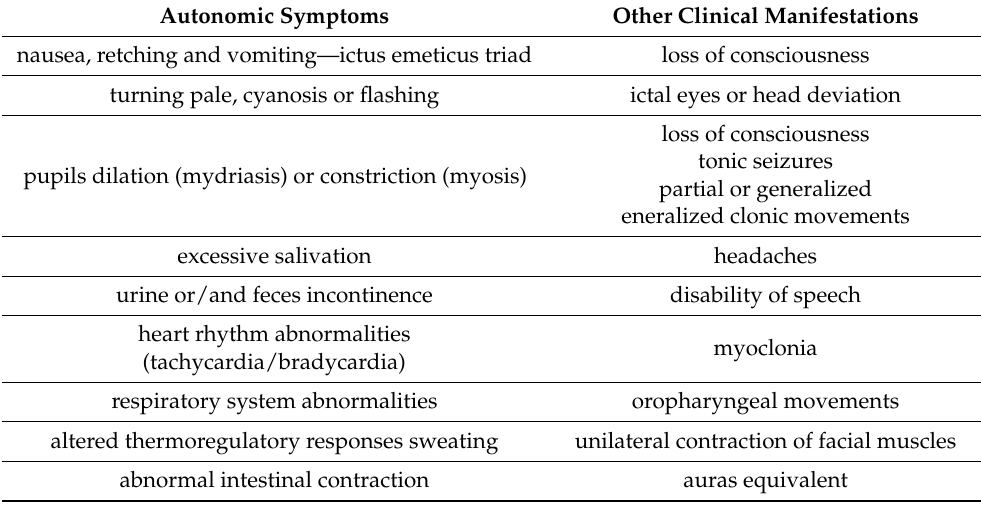
Table 1. The table demonstrates the main autonomic and other clinical manifestations characteristic